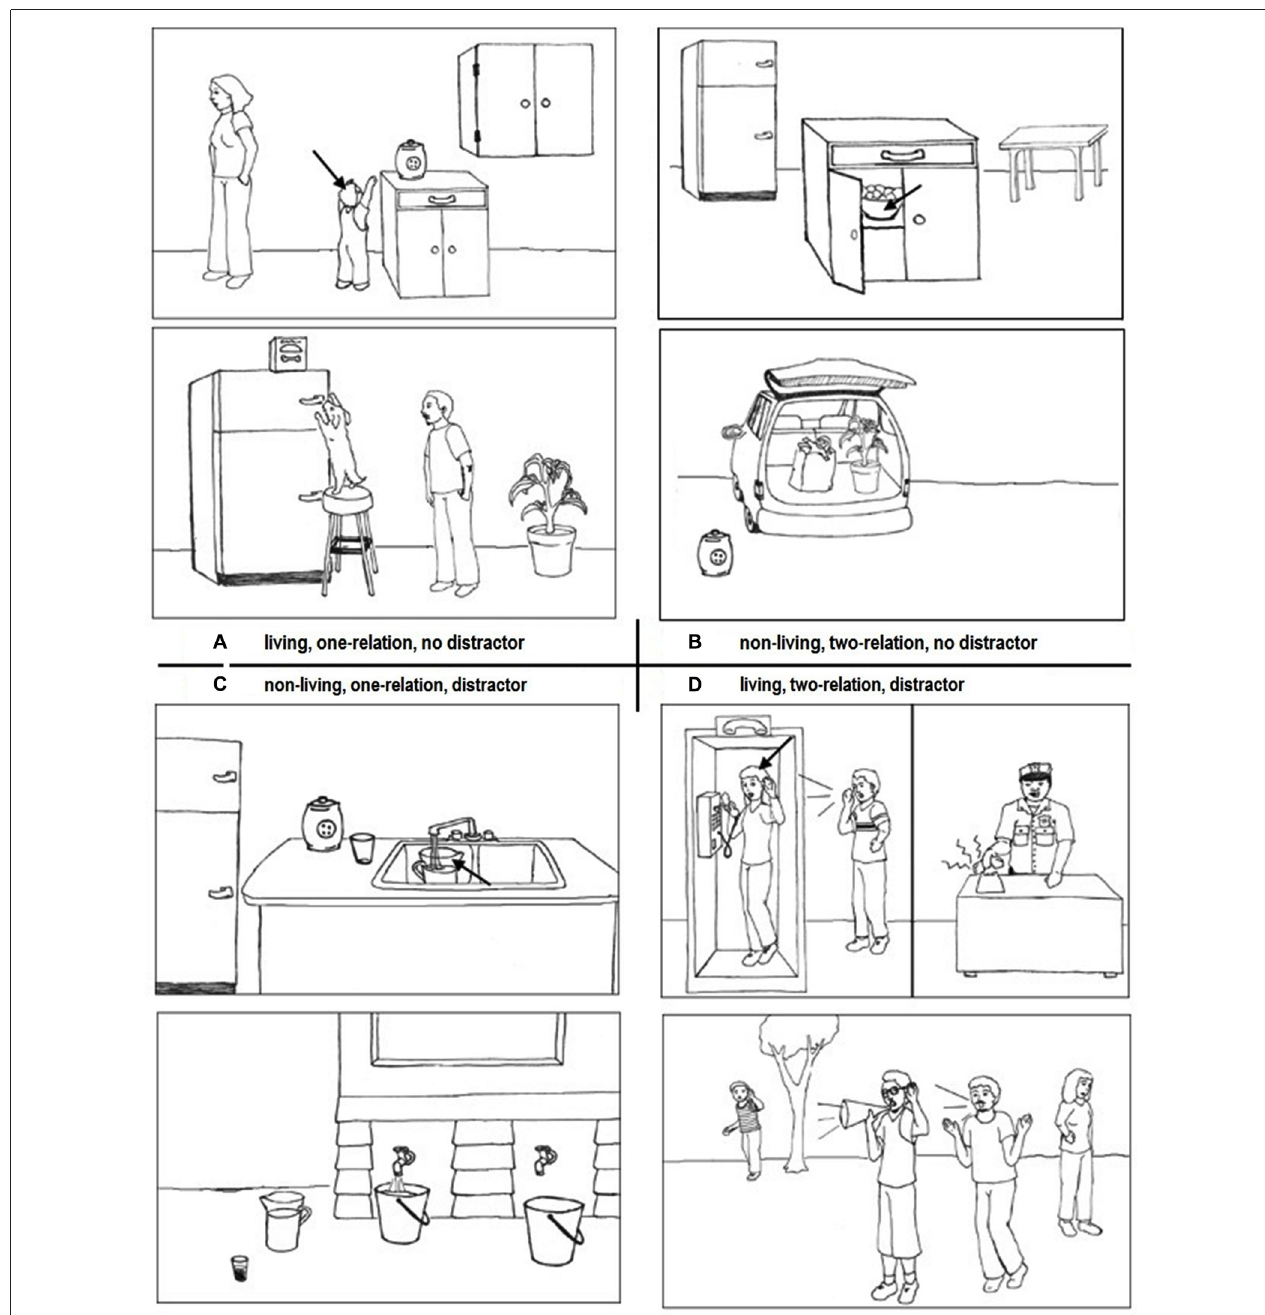
two relations (containing, and being contained), involves non-living objects (food, bowl, cabinet, groceries, bag, and car) with no distraction. Panel C is a one relation problem (containing) with non-living objects (water, pitcher, and bucket), with a distractor present (the pitcher in the lower picture). Panel D consists of two relations (receiving a message and relaying a message), living objects (people), and has a distractor (the woman in the lower picture).